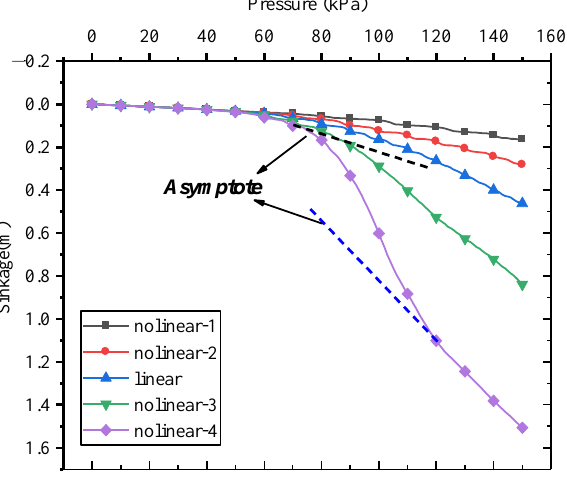
Figure 30. The pressure-sinkage curves of different physical and mechanical properties with soil depth.